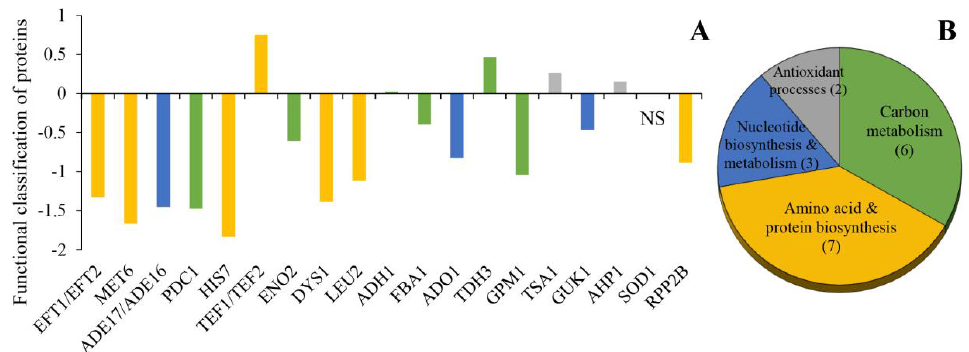
Figure 2. Functional classification of proteins with altered expression in the ∆ sod1 mutant. ( A ) Identified proteins are divided into four functional categories: carbon metabolism—marked in green, amino acid and protein biosynthesis—marked in yellow, nucleotide biosynthesis and metabolism—marked in blue and antioxidant processes—marked in violet. Values above and below zero on the graph indicate protein up- and downregulated, respectively. NS—no protein spot for the ∆ sod1 mutant. ( B ) Number of identified proteins in each category and the proportion between them are shown in the pie chart.